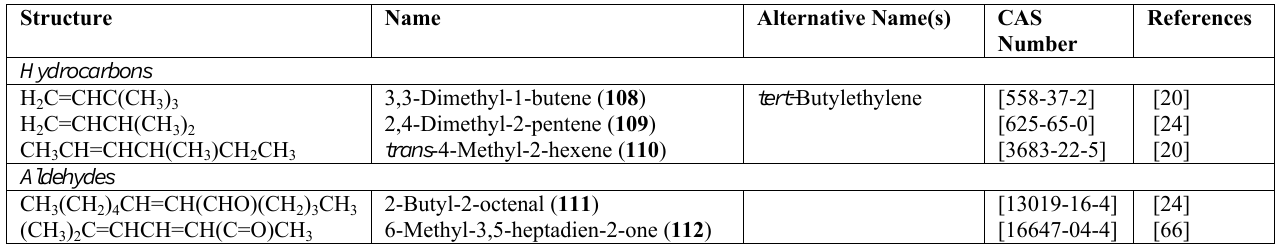
Table 8. Branched Alkenic Hydrocarbons and Aldehydes.